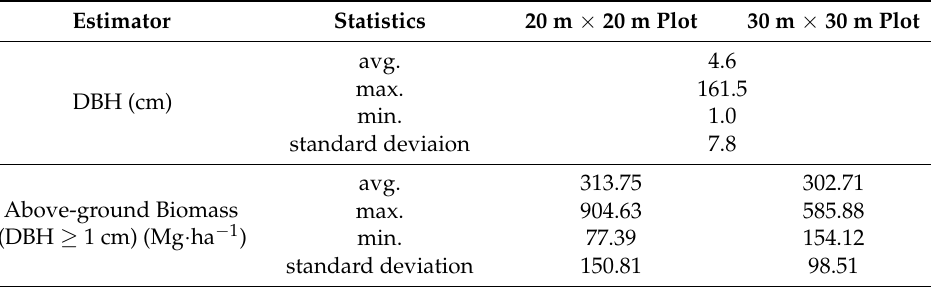
Table 1. Descriptive statistics of the field inventory